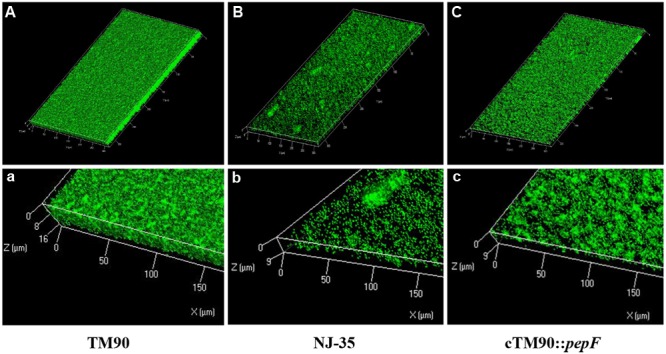
CLSM images of the 24-hour-old biofilms of the wild-type strain NJ-35, mutant strain TM90 and complementation strain cTM90::pepF. The viable cells presented green fluorescence. (A–C) Represent CLSM images of NJ-35, TM90, and cTM90::pepF, respectively. (a–c) The enlarged areas of the bottom left of the (A–C) images and show the local three-dimensional features of NJ-35, TM90, and cTM90::pepF, respectively.